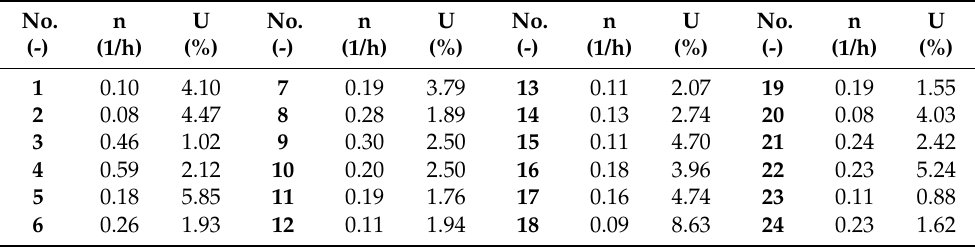
Table 2. Calculated differences and margin of error of the air change rate established by calculations according to measurements of CO